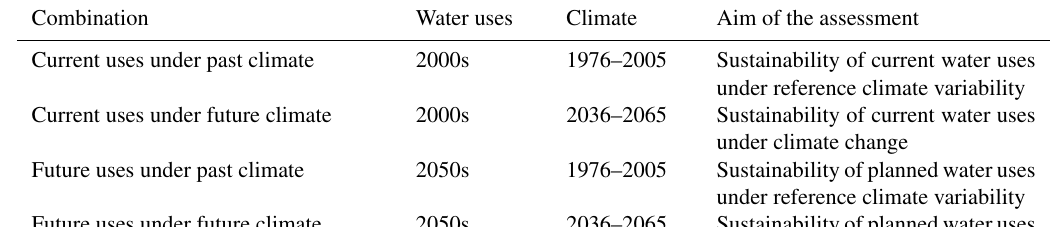
Table 2. Four combinations of climate and water use scenarios applied in the Herault and the Ebro basins.